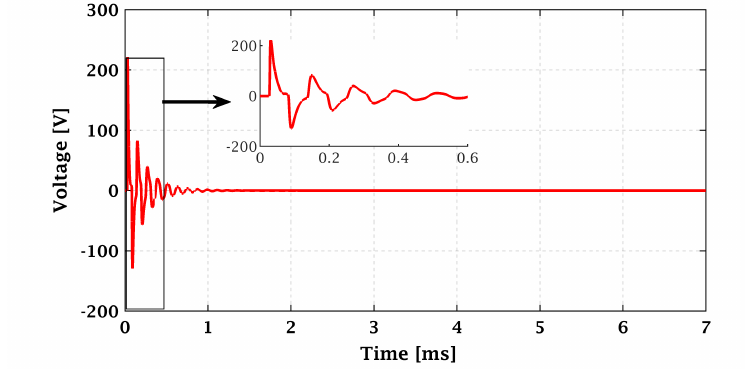
Figure 5. Correlation coefficient value and normalised signal energy as a function of GFL ( x g ). The test fault location is 8 km.